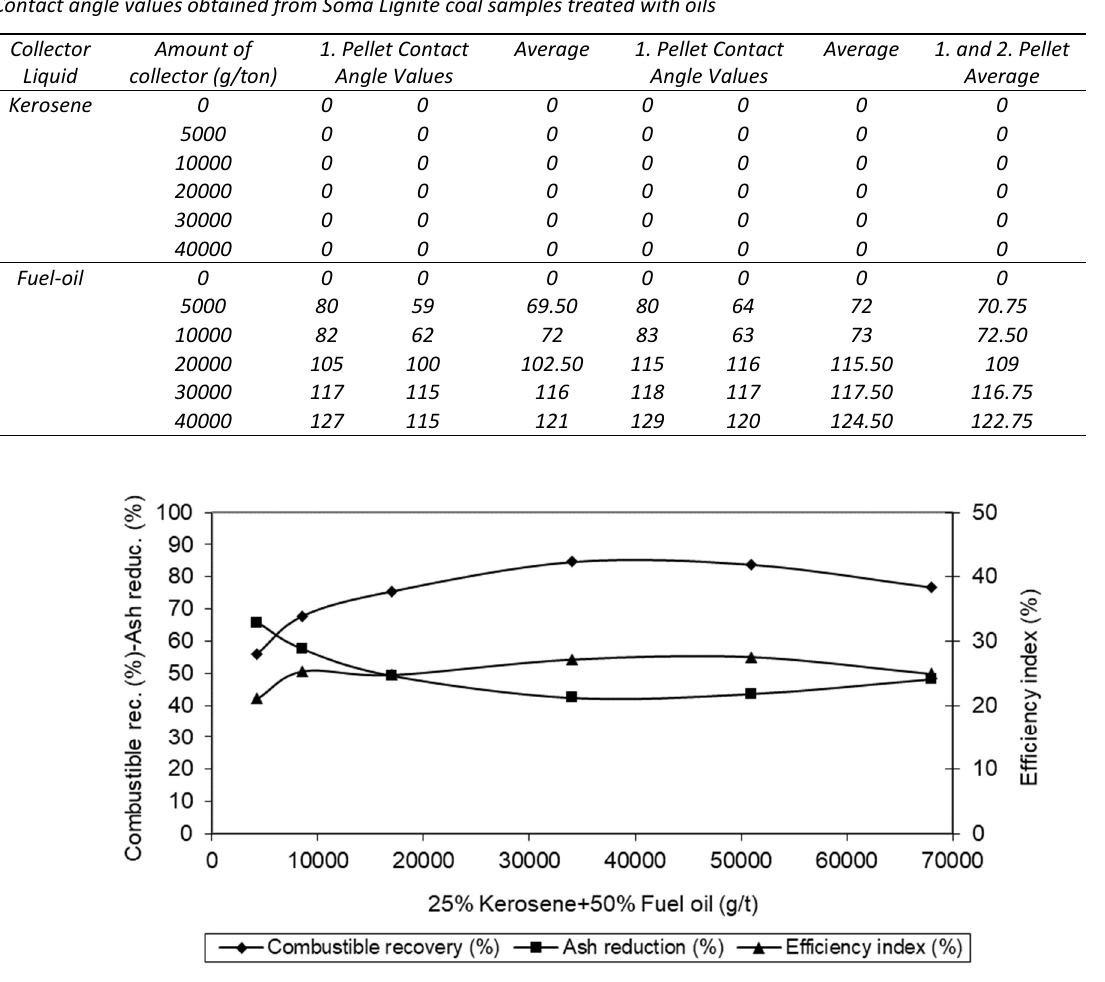
Fig.5 . Effect of 25% kerosene + 75% fuel oil concentration on combustible recovery, ash reduction and efficiency